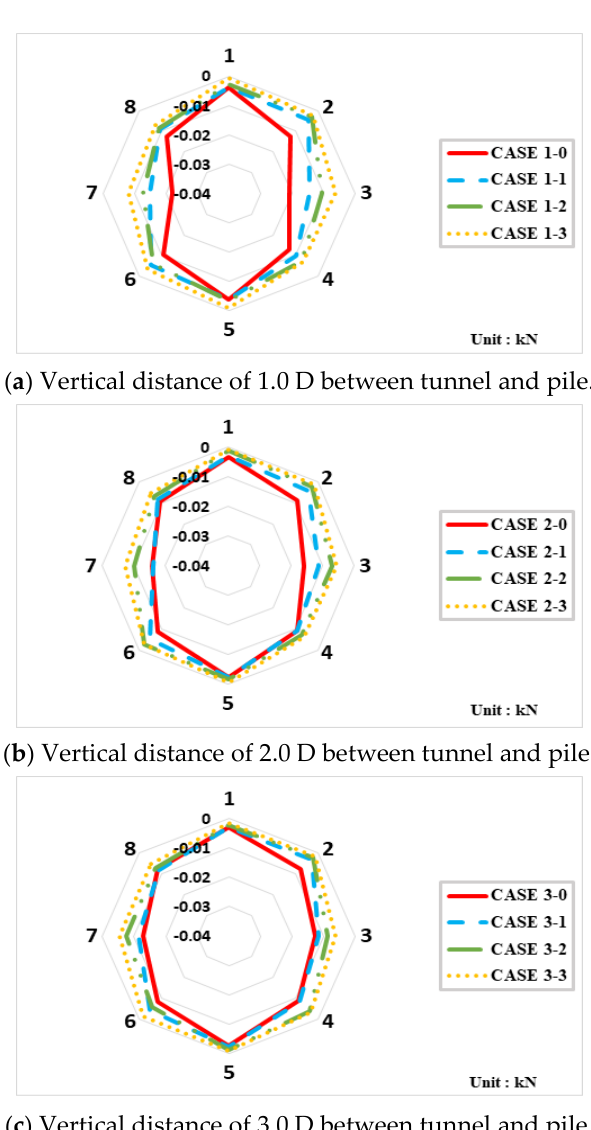
Figure 24. Axial force on tunnel by ultimate load in 3D numerical analysis.